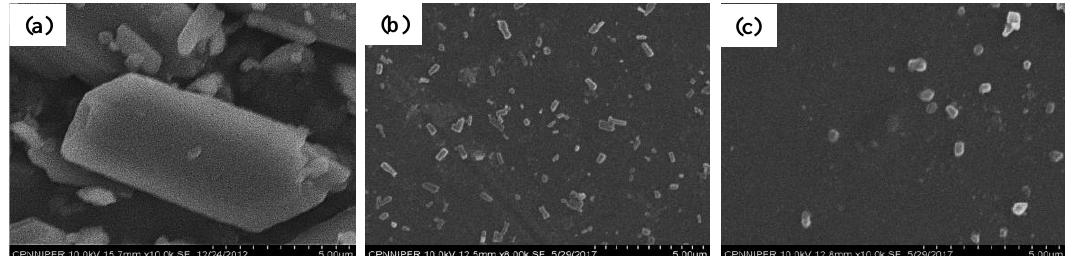
Figure 3. Scanning Electron Microscopy (SEM) photographs of ( a ) DPM, ( b ) NS and ( c ) NSD.